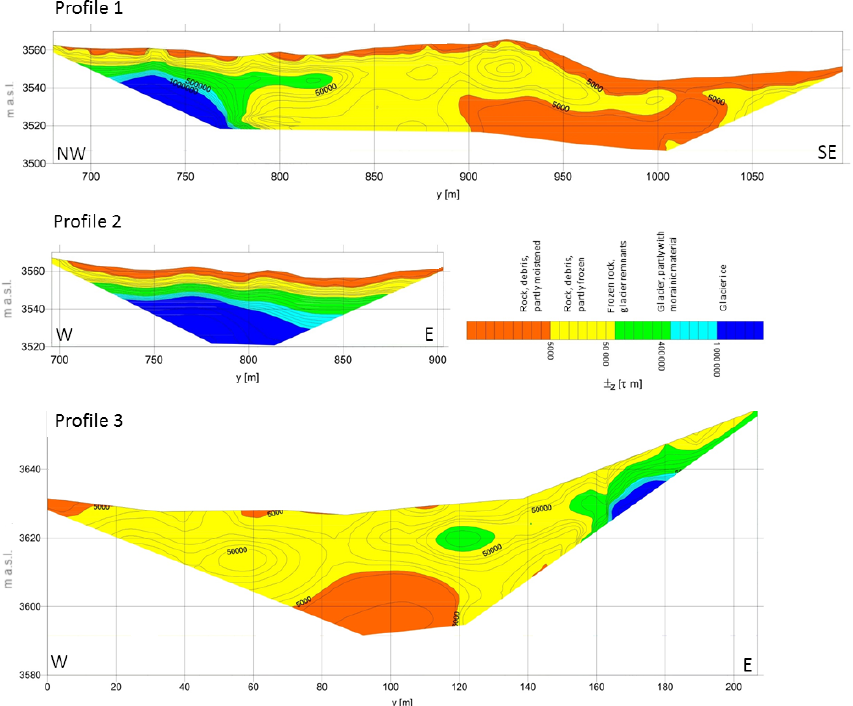
Figure 3. Electrical resistivity results along Profile 1 and Profile 2 for Lake 2 and Profile 3 for Lake 3. Resistivity values of materials depend on grain size, pore size, water content, salinity, temperature, and phase resistivity increases due to the change from electrically conductive water to non-conductive ice (Kneisel et al., 2008). For location of the profiles (P1–P3), see Fig. 1a.